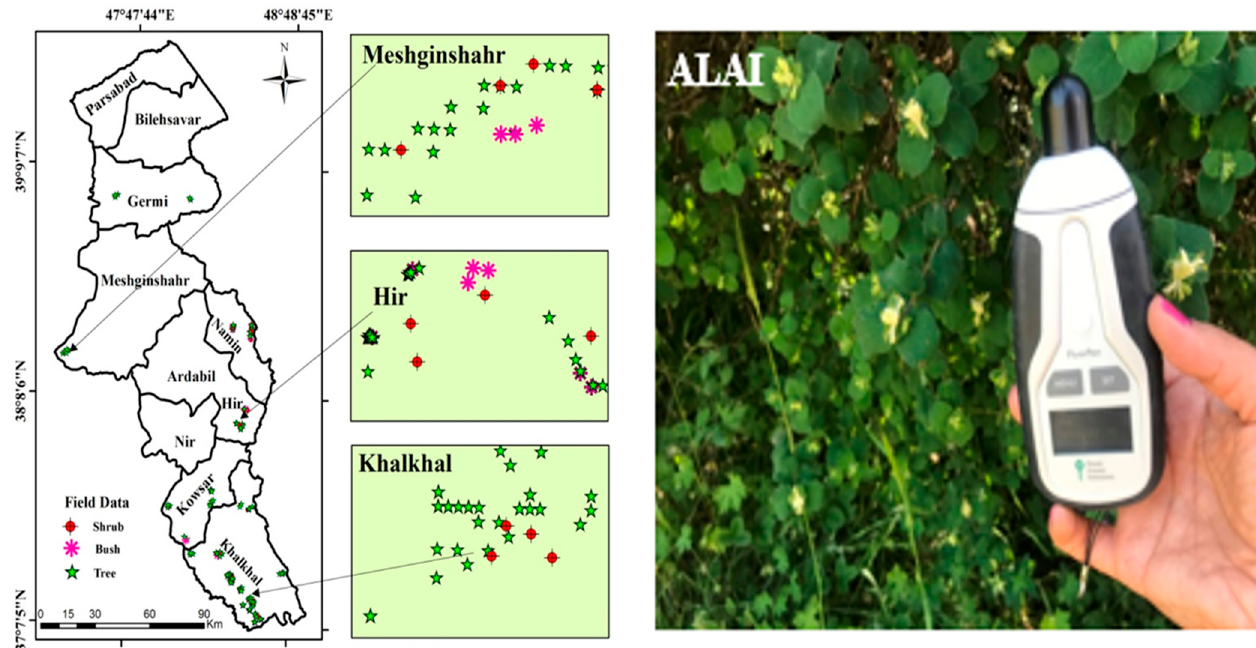
Figure 3. Location of ground truth points ( Left ) and LP 100 application for ALAI calculation in the study area ( right ; e.g., Namin highlands).